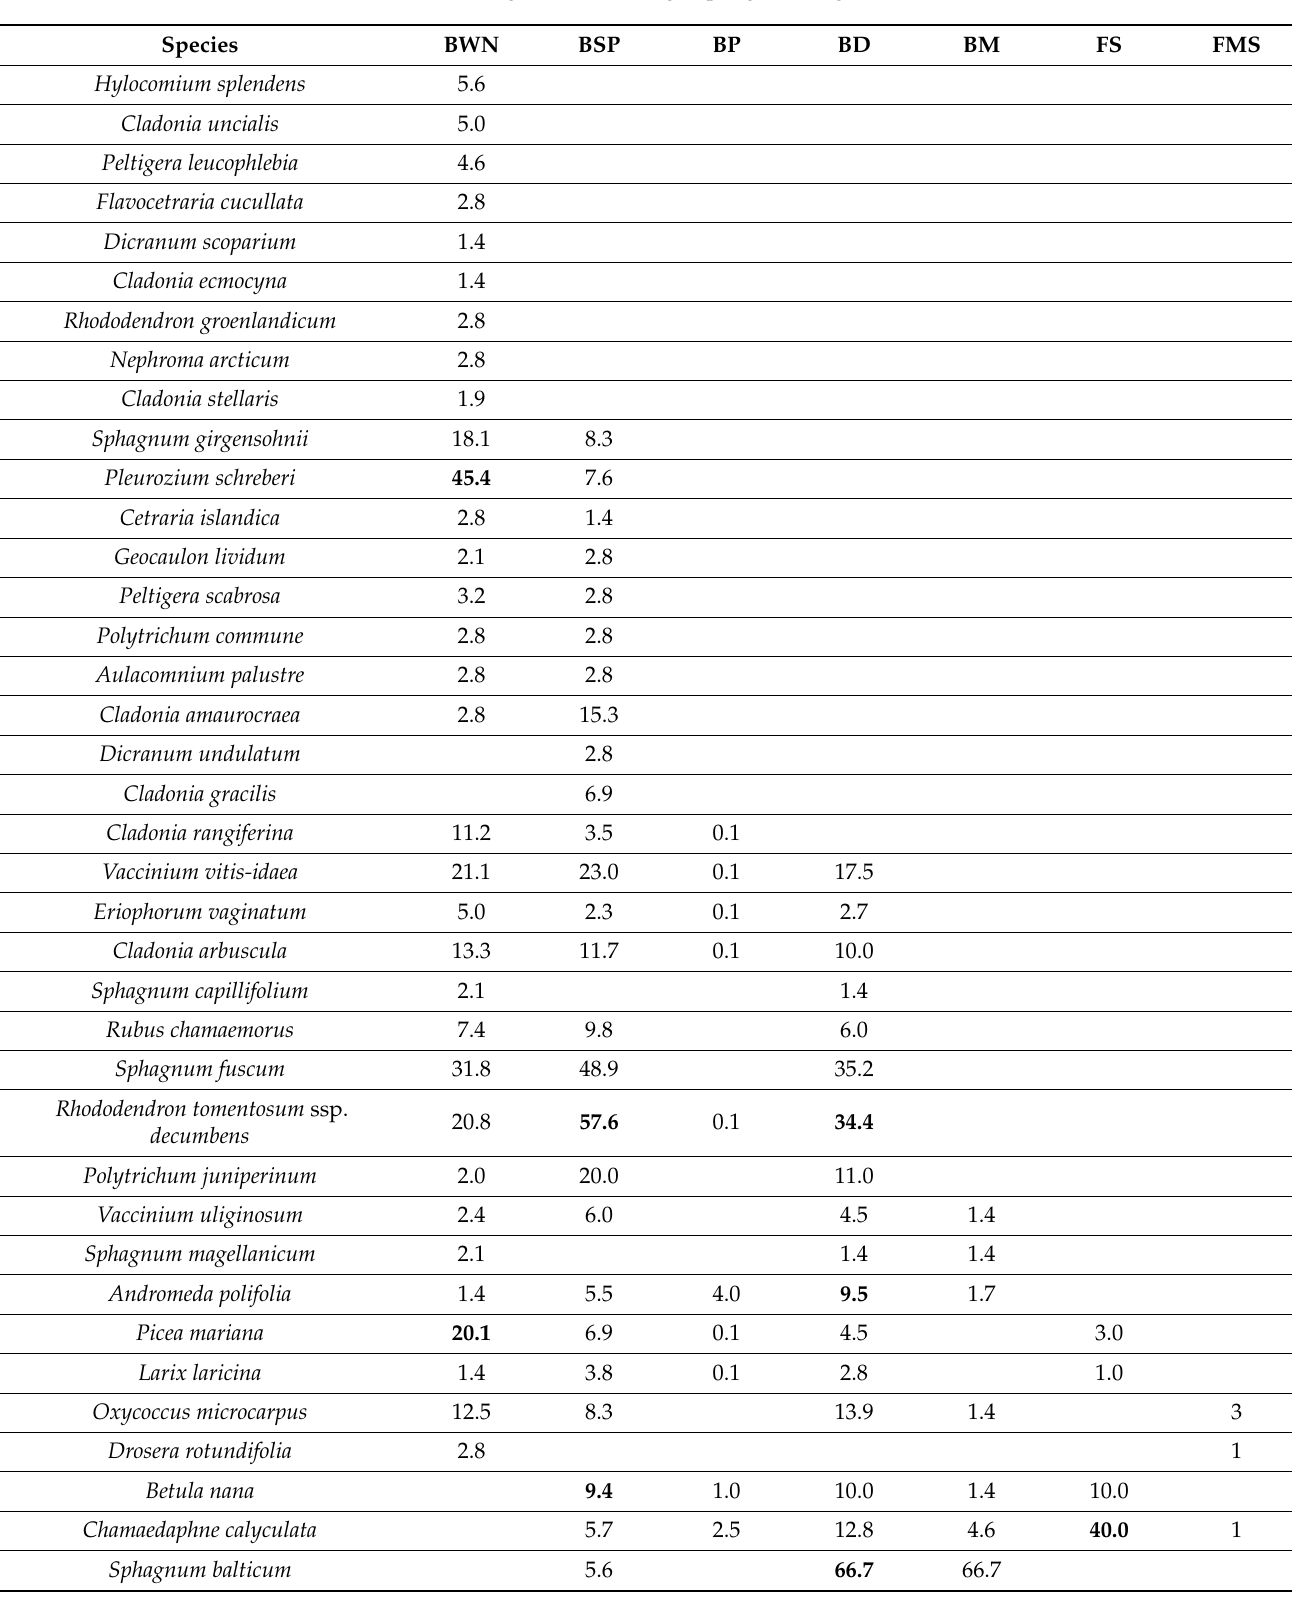
Table 1. Mean vegetation cover (%) by ecotype listed along an environmental gradient. Ecotypes are BWN—black spruce bog, BSP—post-fire scrub bog, BP—partially vegetated bog (new